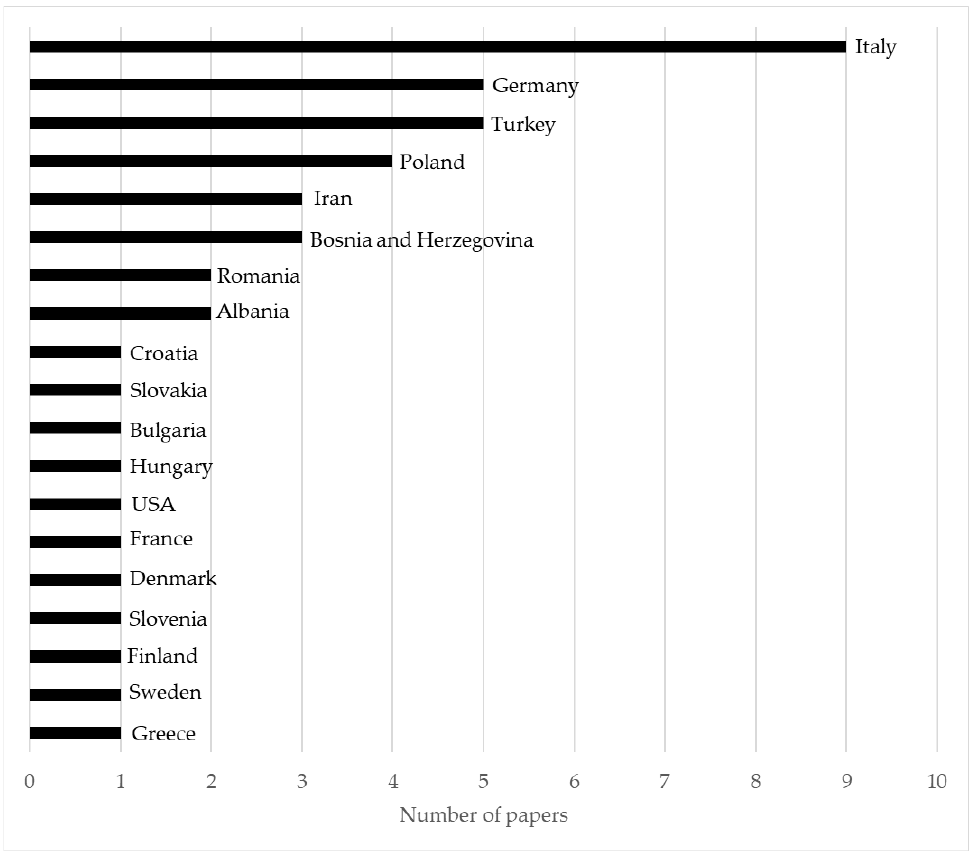
Figure 2. Distribution of the investigated studies among countries.